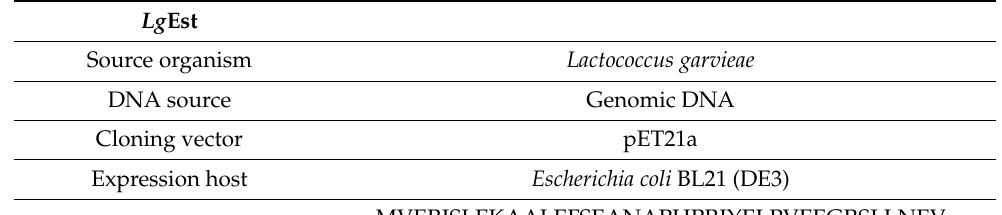
Table 1. Recombinant Lg EstI protein production information.